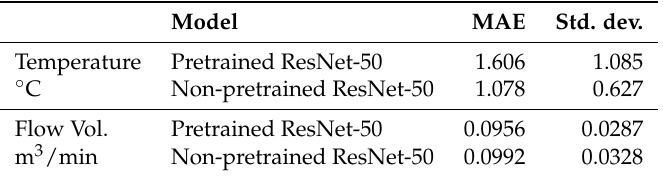
Figure 6. Examples of input, regenerated air-conditions and the difference in a small room. Table 2. MAE of regenerated temperature and airflow volume in a small room.